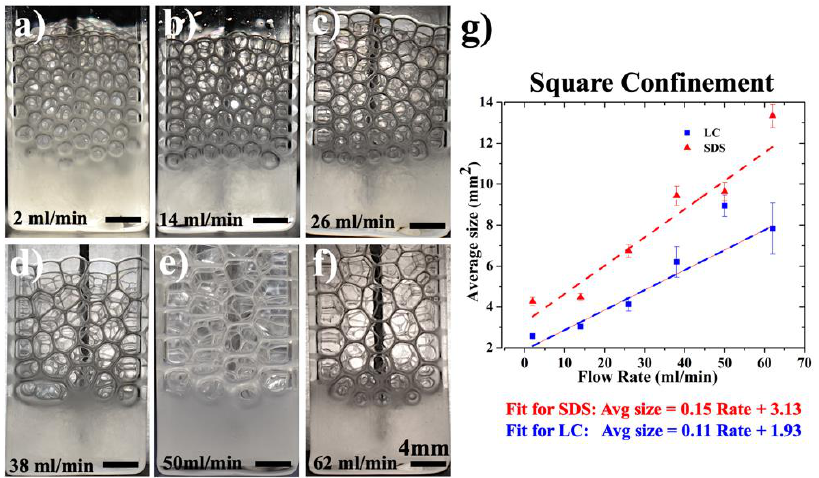
Figure 3. Fabrication of smectic foam under square confinement. The square containers are glass vials with a side length of 15.78 mm. Images of LC foams created at an airflow rate of ( a ) 2 mL/min, ( b ) 14 mL/min, ( c ) 26 mL/min, ( d ) 38 mL/min, ( e ) 50 mL/min, and ( f ) 62 mL/min. ( g ) Average area of the foam cells near the container’s wall for LC (squares) and SDS (triangles) as a function of the airflow rate.